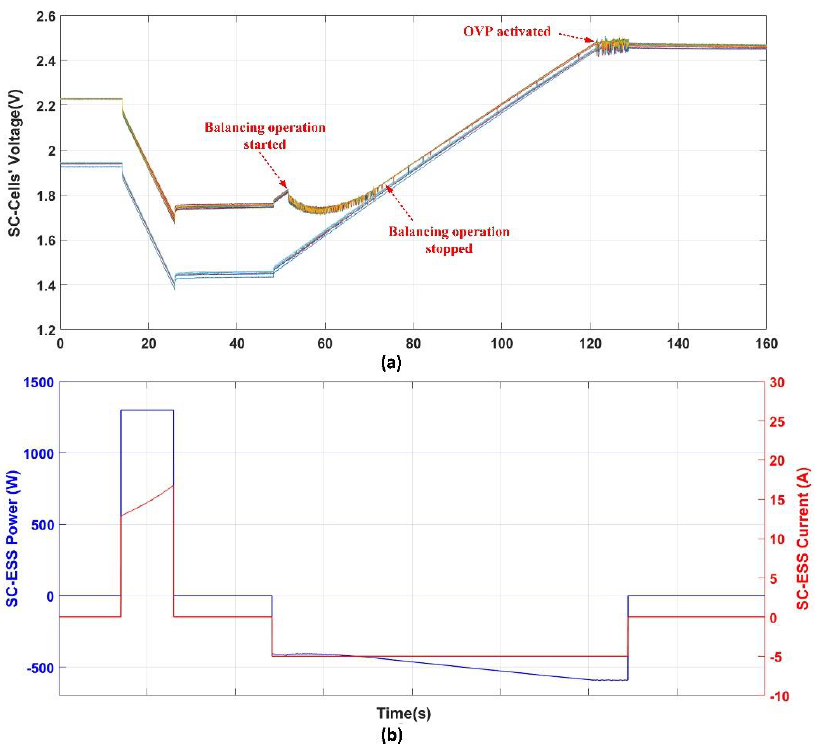
Figure 11. Performing preventive action by OVP subsystem via active dissipative balancing during the continuous charge cycle: ( a ) SC cells’ voltages; ( b ) Charge/discharge power and current.